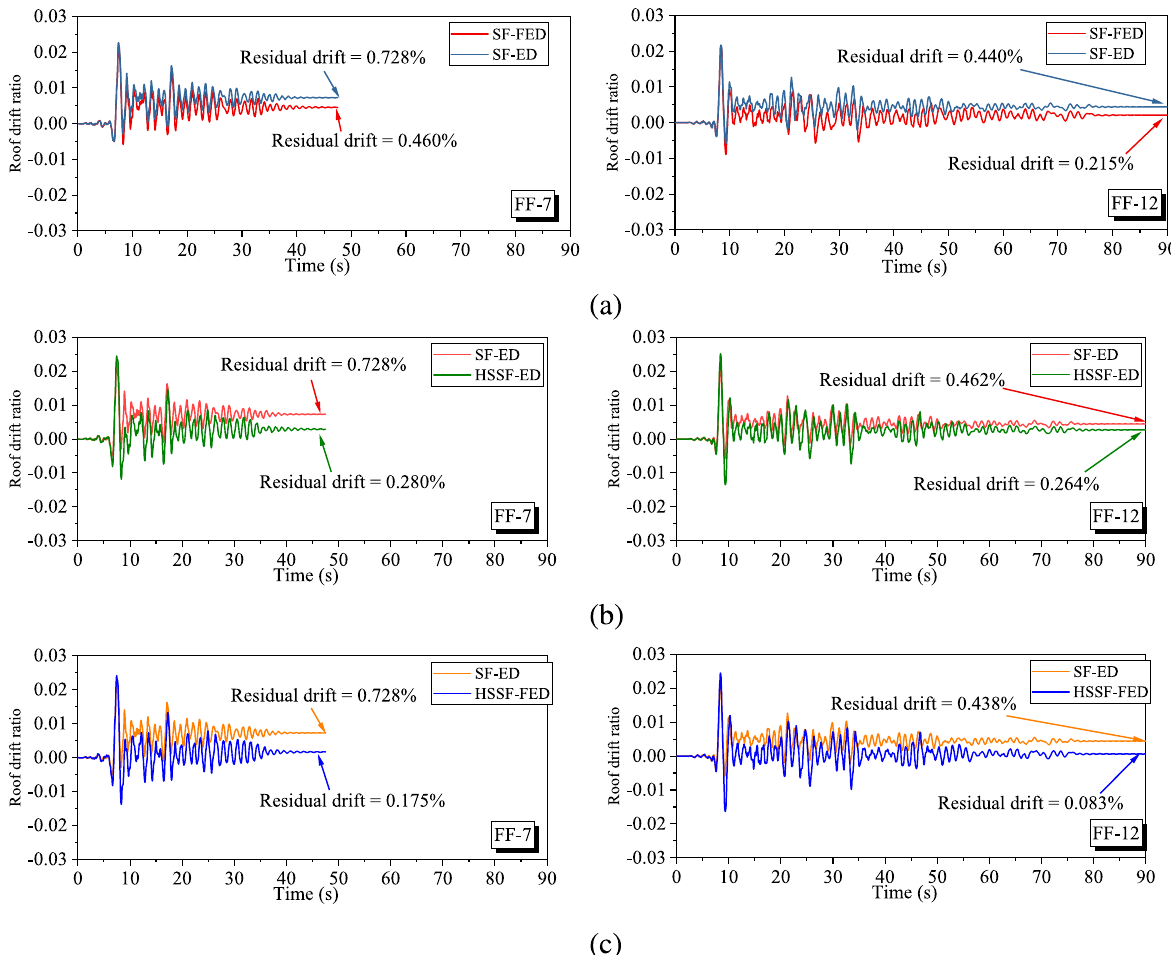
Fig. 25 Roof drift ratio of structures under FF‑7 and FF‑12 earthquake ground motion (MCE